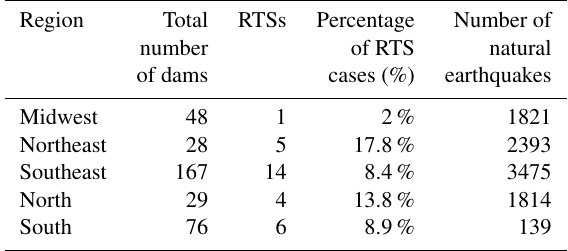
Table 3. Number of dams, RTSs and natural earthquakes by country